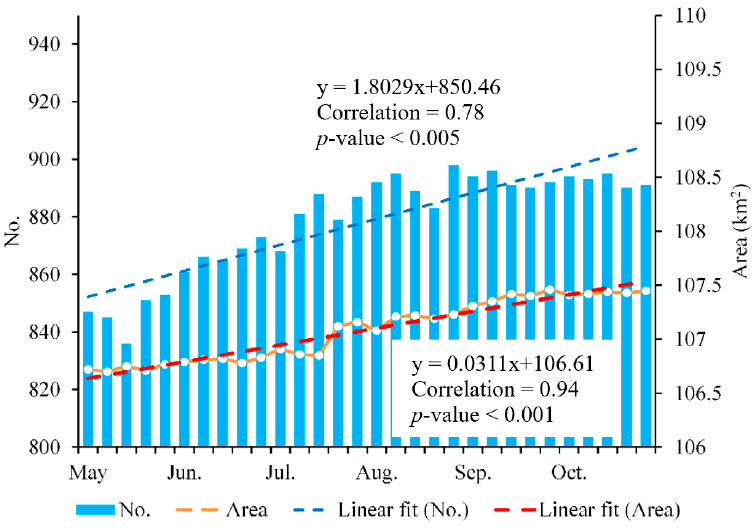
Figure 6. Seasonal changes in the number and area of glacial lakes from May to October 2018.